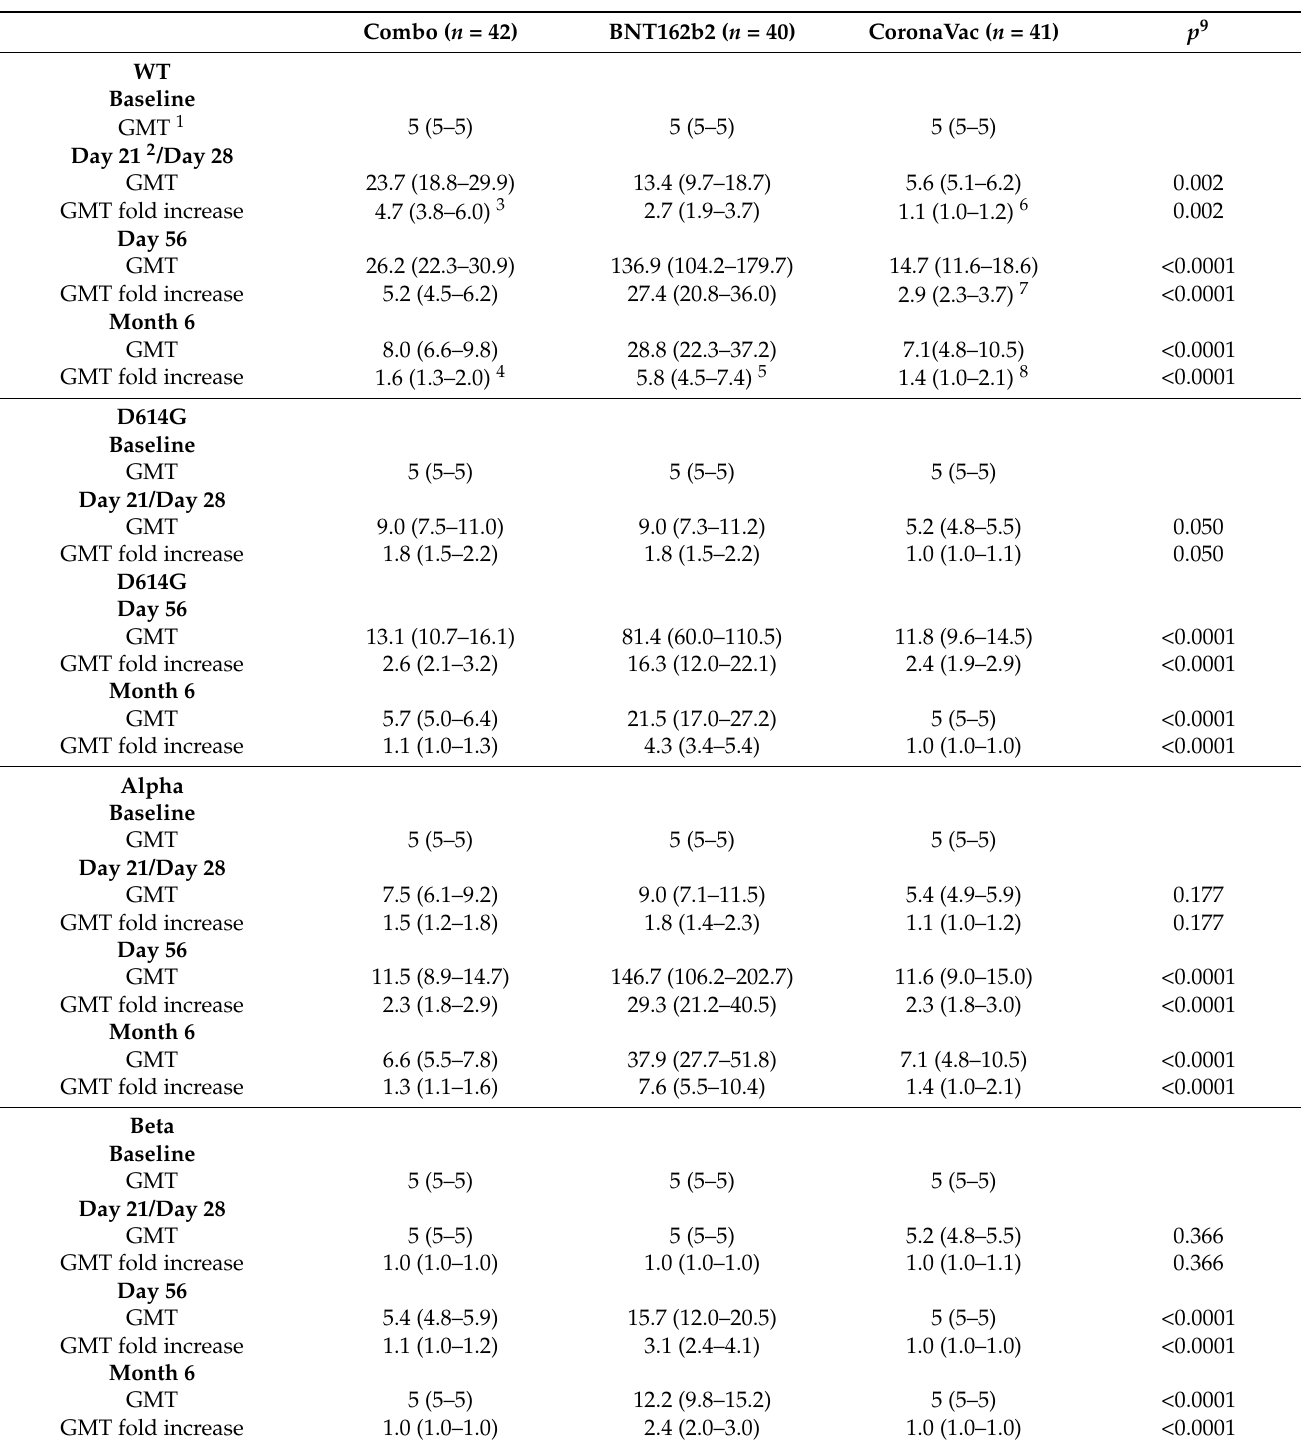
Table 2. Immunogenicity of different vaccination